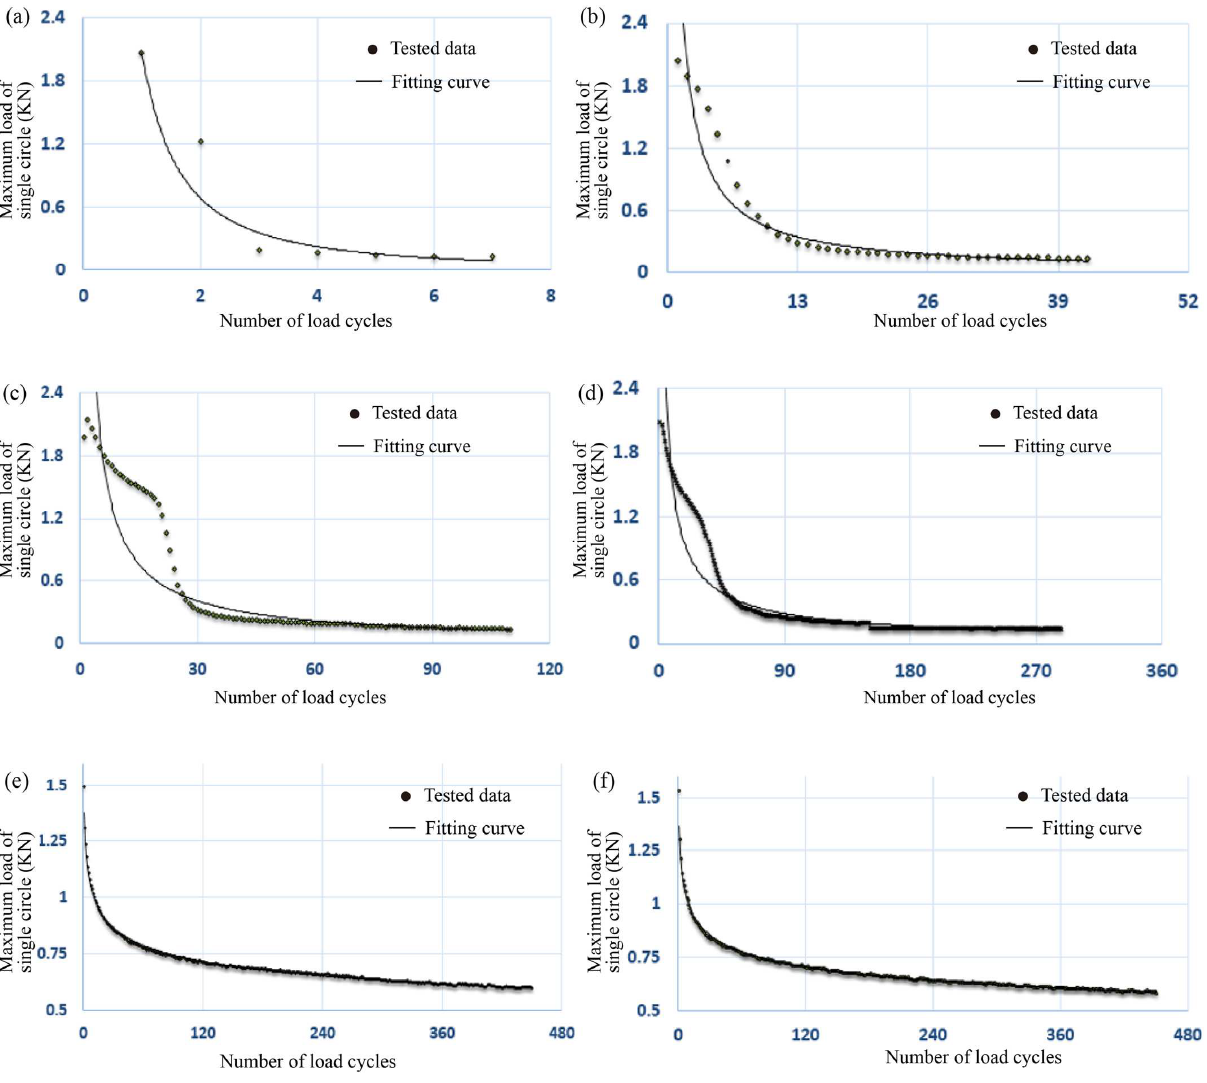
Figure 3. OT results: ( a ) AC-13 (−10 °C); ( b ) AC-20 (−10 °C); ( c ) AC-13 (0 °C); ( d ) AC-20 (0 °C); ( e ) AC-20 (25 °C); ( f ) AC-20 (25 °C).